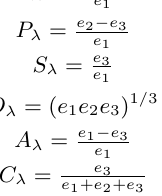
Figure 4. Example of point cloud pre-processing: mast (blue) and railway track (red line). (a) and (b) original data, (c) and (d) local reference system with y (cid:48) coordinate aligned with the railway track.